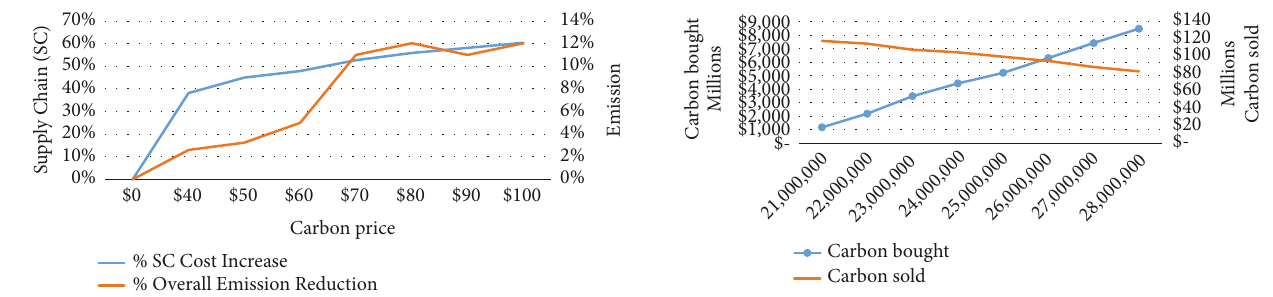
Figure 2: Cost increase and emission reduction performance. Figure 3: Carbon bought and sold with carbon cap variations.